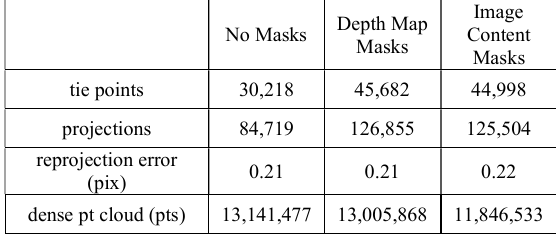
Table 2. PhotoScan processing results for masking methods of Mango Vase f/5.6 image sets